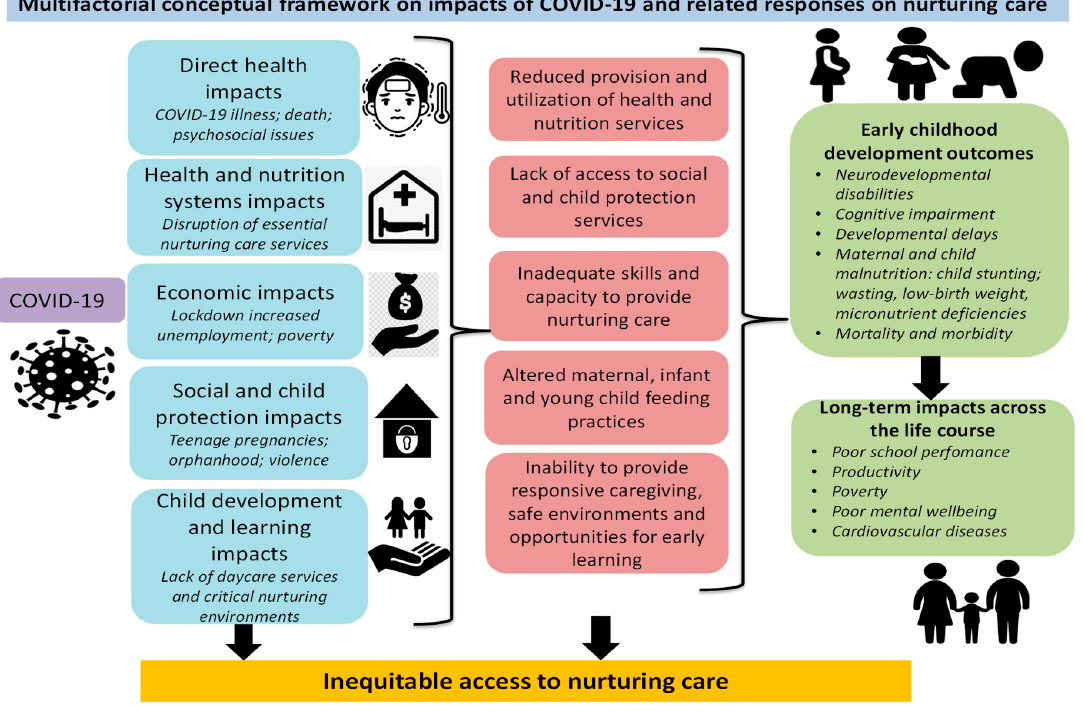
Figure 1. Authors’ conceptualization of the impacts of Coronavirus disease 2019 (COVID-19) on nurturing care.